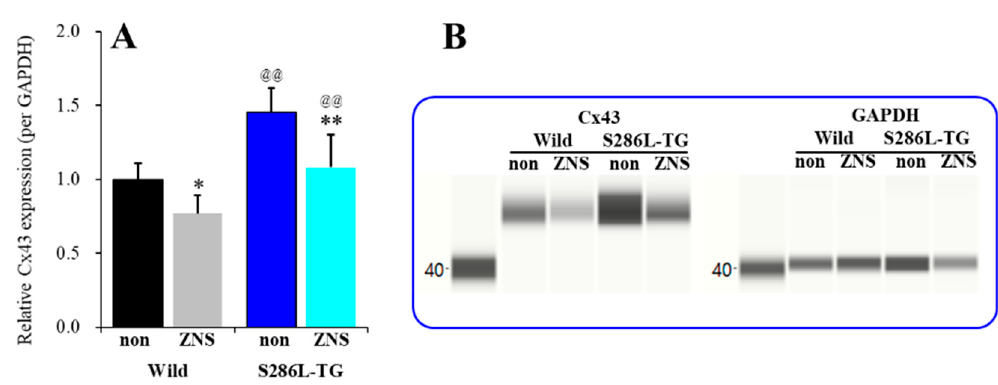
Figure 4. E ff ects of systemic subchronic administration of ZNS (40 mg / kg / day for 7 days) on Cx43 expression in the M2C plasma membrane fraction of wild-type and S286L-TG ( A ) and pseudo-gel images using Simple Western results using anti-GAPDH and anti-Cx43 antibody for blotting of plasma membrane fractions ( B ). In panel 4A, ordinate: mean ± SD (n = 6) of relative protein level of Cx43. * P < 0.05, ** P < 0.01 vs. ZNS-free (non) and @@P < 0.01 vs. wild-type by two-way analysis of variance (ANOVA) with Tukey’s post hoc test.